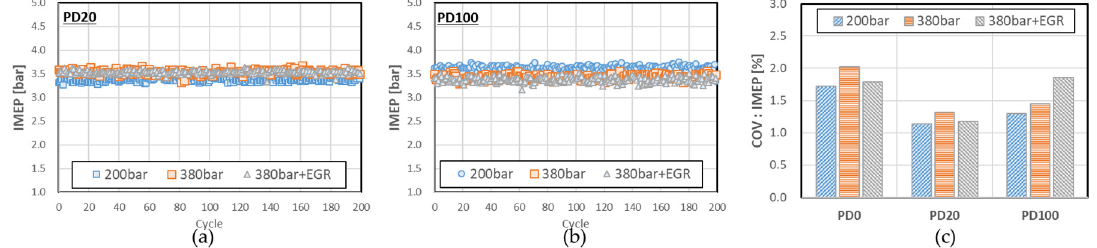
Figure 7. The variation of indicated mean effective pressure (IMEP) and coefficient of variation (COV). ( a ) IMEP of PD20, ( b ) IMEP of PD100, and ( c ) COV of IMEP.